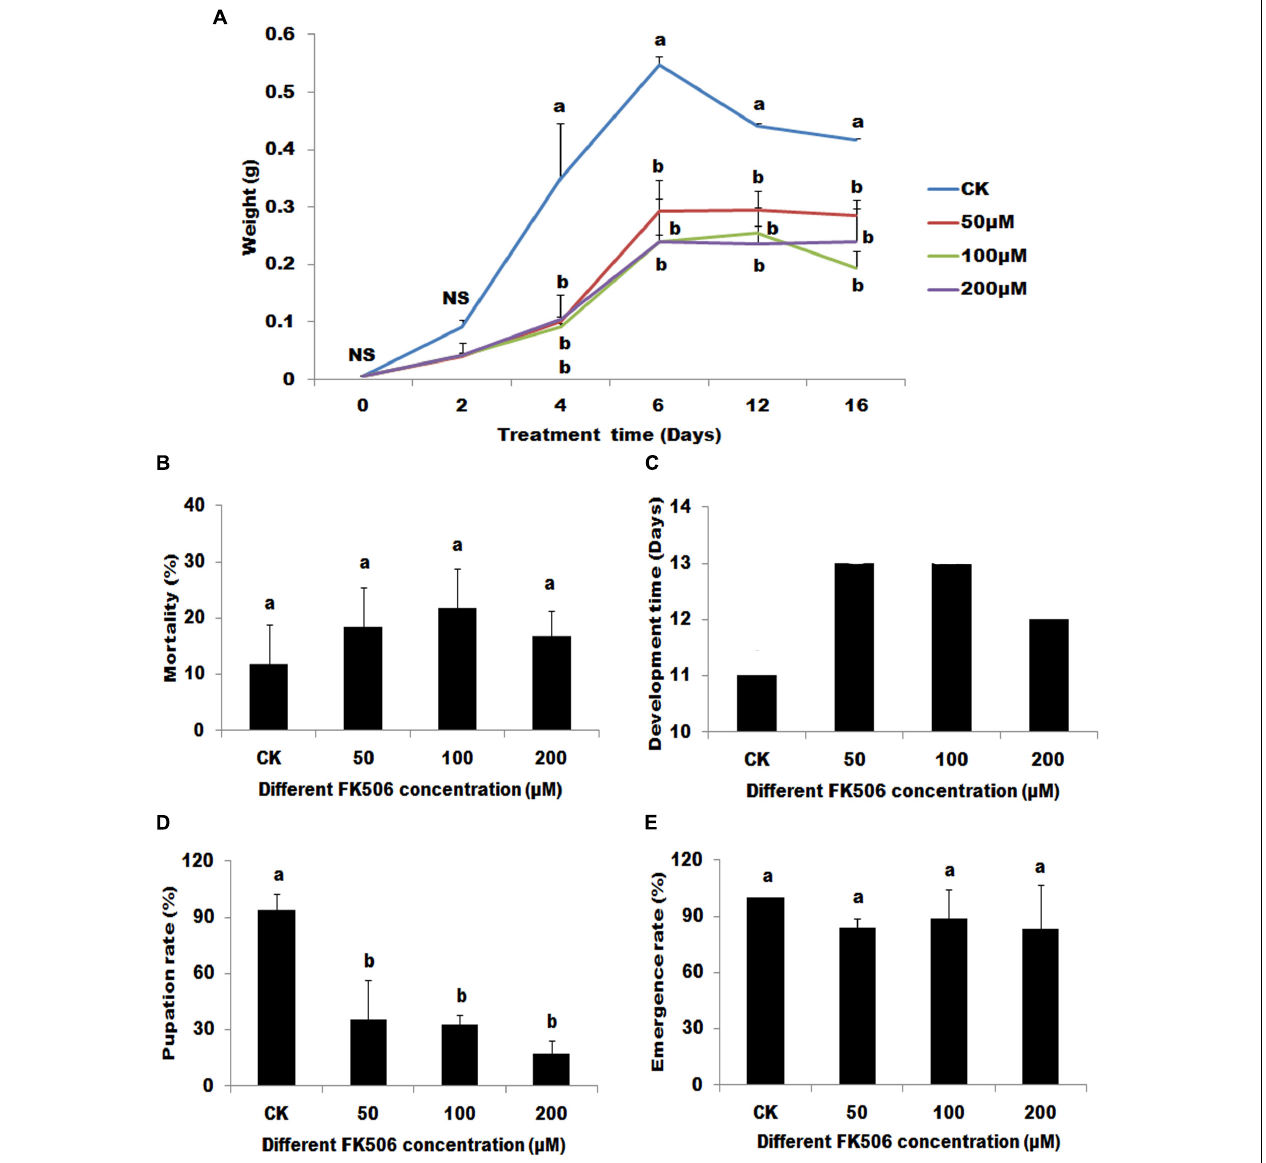
FIGURE 2 | Effects of the calcineurin (CN) inhibitor (FK506) on the Helicoverpa armigera . The larvae were treated begin at the first day of 3rd. (A) The effect of FK506 on the larvae weight. Larvae were fed with different FK506 concentrations (50, 100, and 200 µ M) (DMSO as buffer control). (B) The mortality of larvae 7 days after different treatments. (C) The developmental time of the different treatments from the first day of 3rd instar larvae to began to pupate. (D) The pupation rate of the different treatments. (E) The emergence rate of the successfully pupate insects under the different treatments. Statistically significant differences for experimental comparisons are indicated by different small letters [analysis of variance (ANOVA) and Tukey’s test, P < 0.05; DPS7.05]. Values shown are means and standard errors.